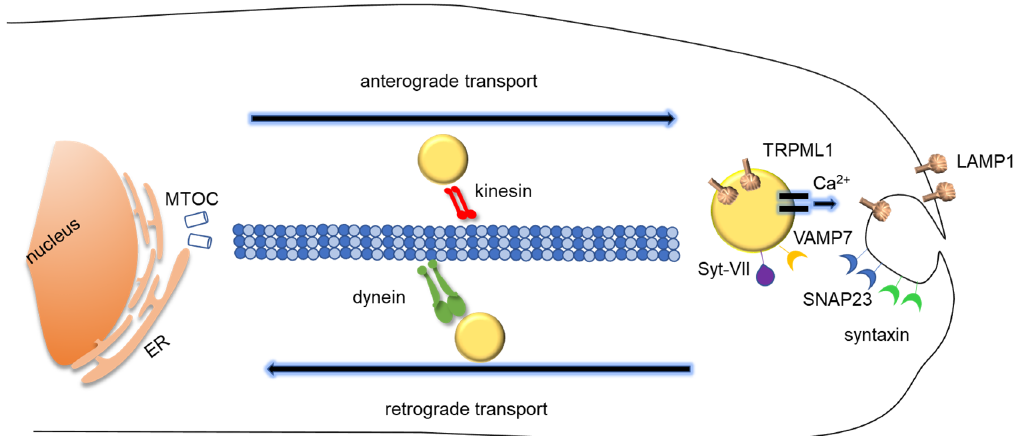
Figure 2. Schematic representation of lysosomal exocytosis. Lysosomes migrates from the perinuclear region to plasma membrane proximity and fuse with the plasma membrane, releasing their content extracellularly. Most lysosomes are localized around the nucleus, but a pre-requisite for lysosomal exocytosis is their transport in the proximity of the plasma membrane along microtubules via kinesin motor proteins. The dynamics of lysosomes within cytoplasm also includes the retrograde transport from periphery to nucleus along microtubules, mediated by dynein motor proteins. Vesicle-associated membrane protein 7 (VAMP7) is present on the surface of lysosomes and interacts with syntaxin-4 and with synaptosome-associated protein of 23 kDa (SNAP23) on the plasma membrane. The lysosomal Ca 2 + channel TRPML1 provides Ca 2 + for lysosomal membrane fusion, which is sensed by Syt-VII. ER, Endoplasmic Reticulum, MTOC, microtubule-organizing